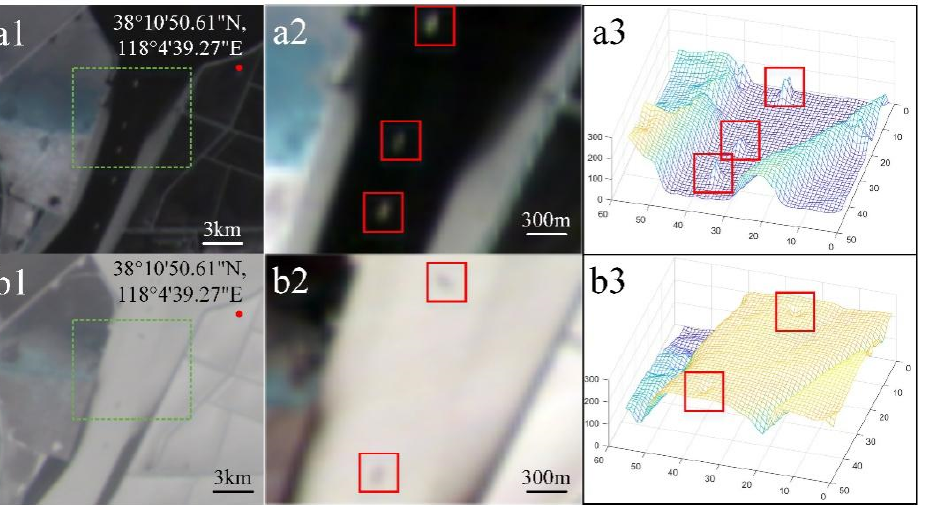
Figure 13. ( a1 ) the daytime image at Bohai port in 38°10 ′ 50.61 ″ N,118°4 ′ 39.27 ″ E ( a2 ) an enlarged image of the green box in a1, ( a3 ) the intensity distribution of a2, ( b1 ) the images at night in the same area as a1, ( b2 ) an enlarged image of the green box in b1, and ( b3 ) intensity distribution of b2 (The red boxes are the ships).